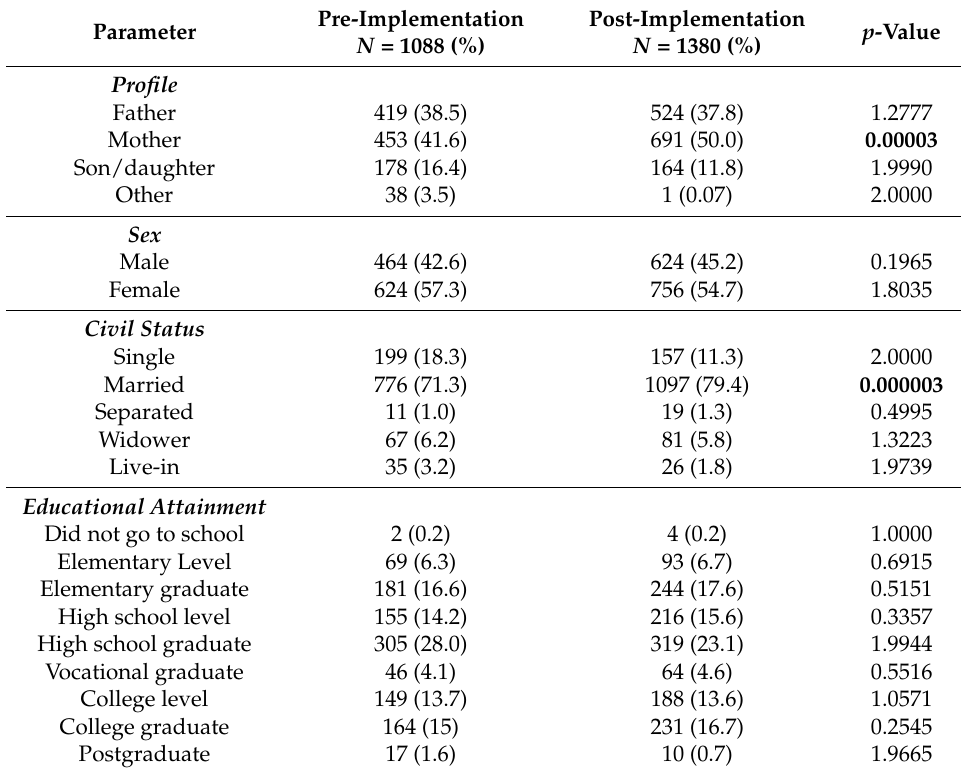
Table 1. Socio-demographic profile of